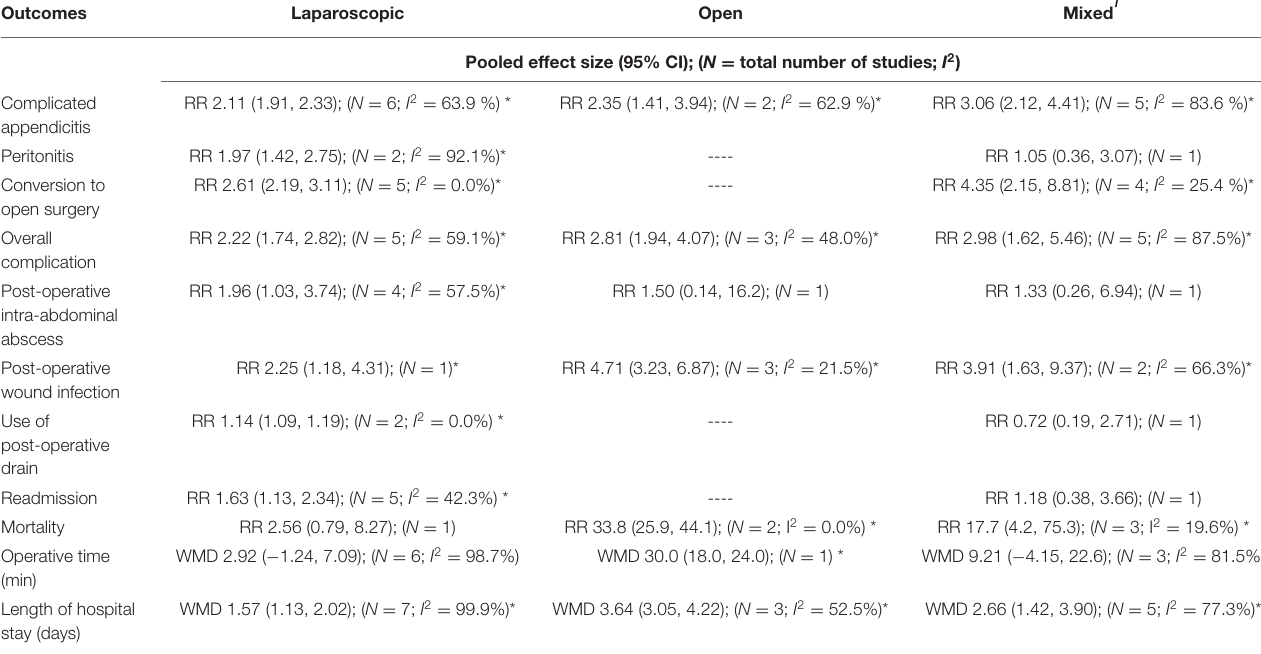
TABLE 2 | Outcomes in elderly, compared to non-elderly, based on the type of appendectomy. Outcomes